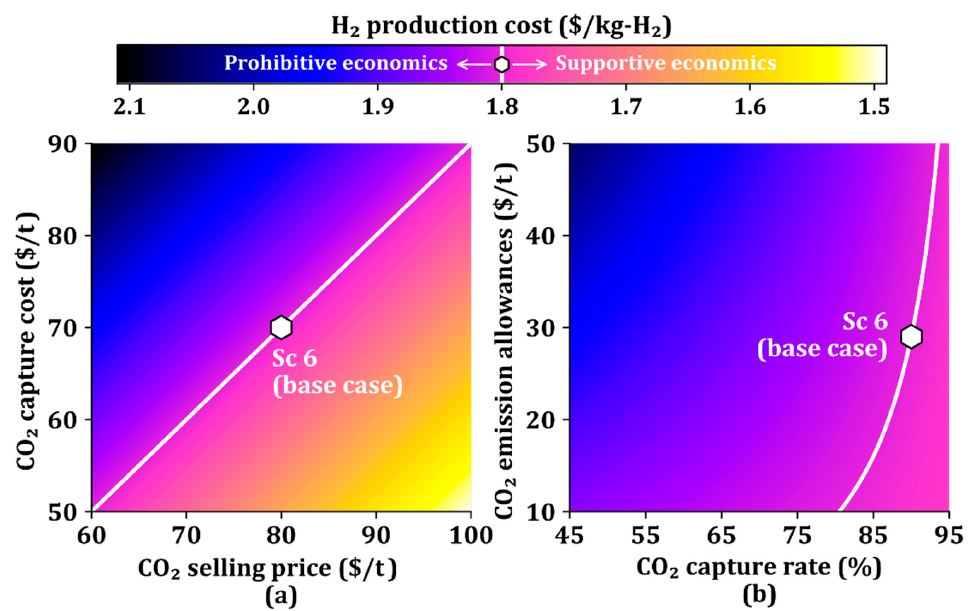
Figure 7. H 2 production cost as a function of ( a ) CO 2 capture cost and CO 2 selling price, and ( b ) CO 2 capture rate and CO 2 emission